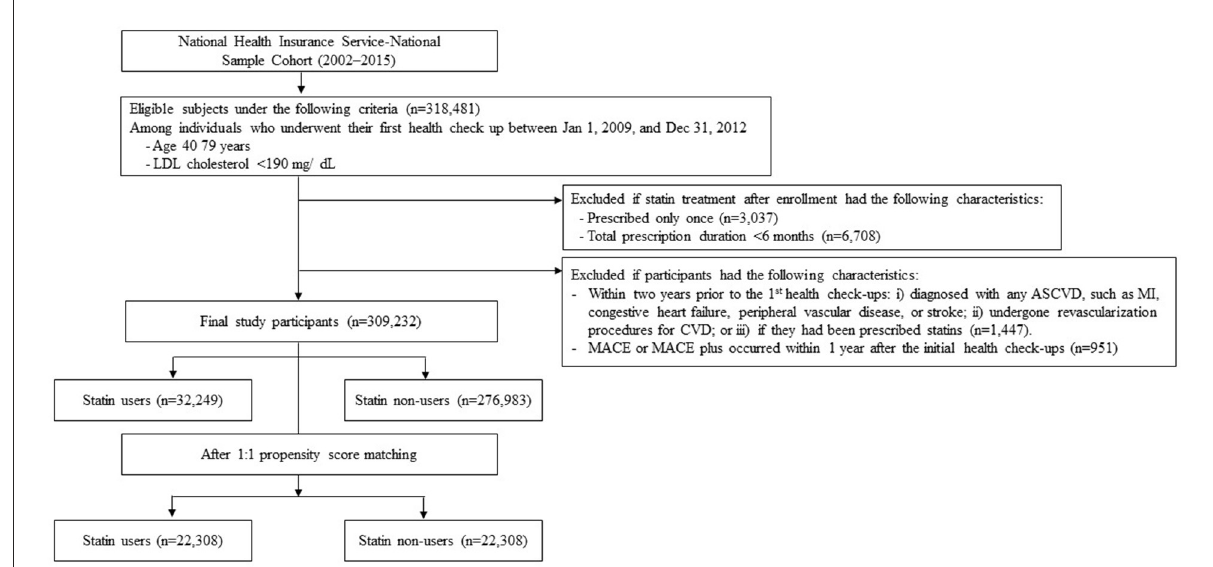
FIGURE1 Flow chart of study participant selection. An illustration of the final study population selection, summarizing the inclusion and exclusion criteria in this retrospective cohort study.